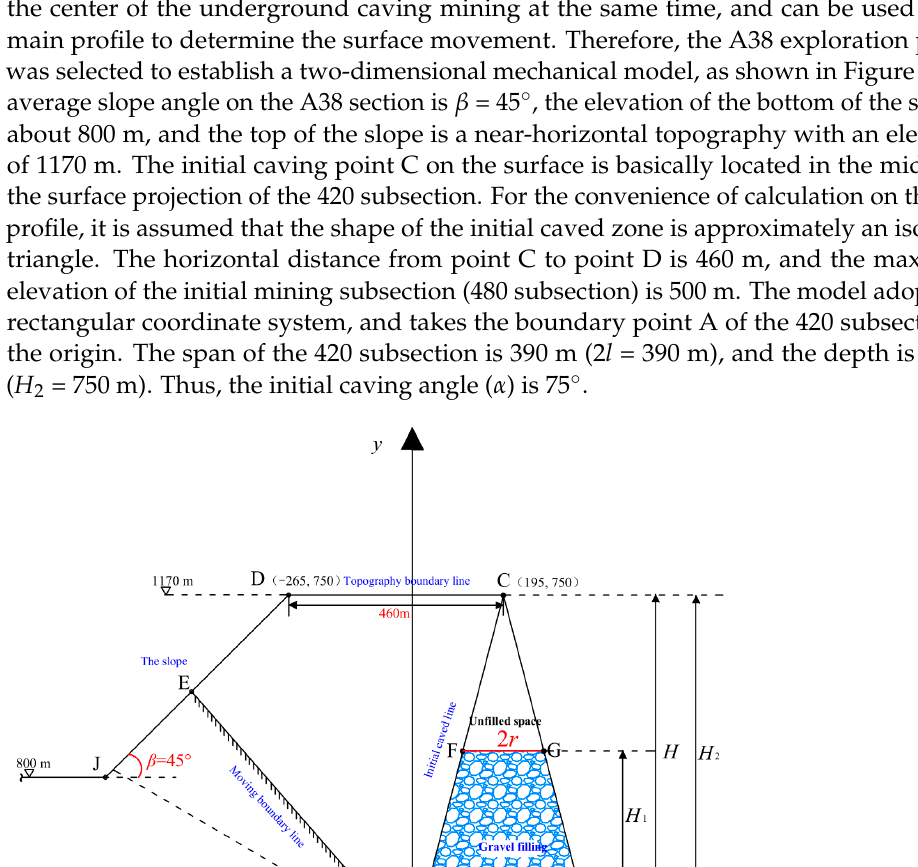
Figure 5. Two-dimensional geometric model of the open-pit and underground caving combined mining based on A38 in the Dahongshan Iron Mine.